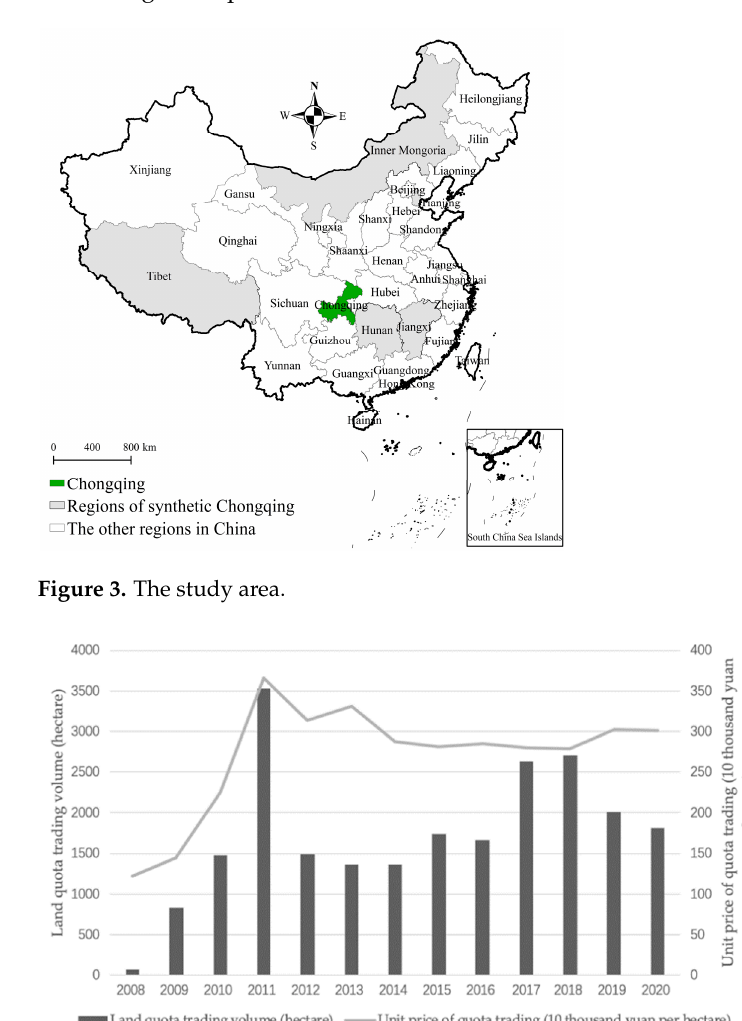
Figure 5. The framework for evaluating the effect of the LQT program. 4.2. Estimation Method and Variable Selection A land quota trading market was established in Chongqing in 2008. This policy pilot area can be regarded as the treatment group, and other provinces and regions comprise the control group. Verifying the policy effect should consider the landing cycle. Chong- qing’s LQT program started at the end of 2008, and there was only one batch of trading. The number of completed transactions was lower during 2009 and steadily increased from 2010 (Figure 4). It should be considered that the effect of the LQT program could be seen from 2010, so 2010 was selected as the processing year.